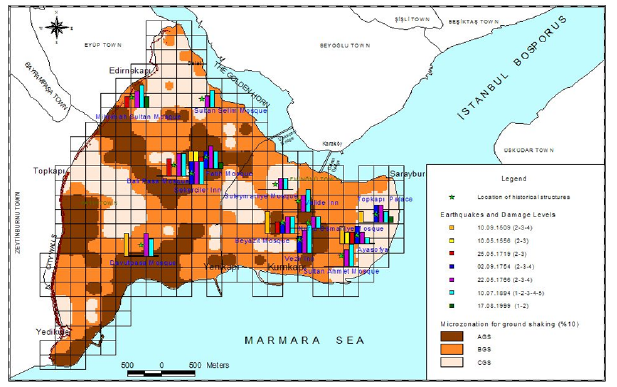
Figure 16. Comparison of damage levels in various earthquakes and the landslide hazard microzonation map prepared for probability of exceedance of 10% in 50yr (˙Ince, 2005).